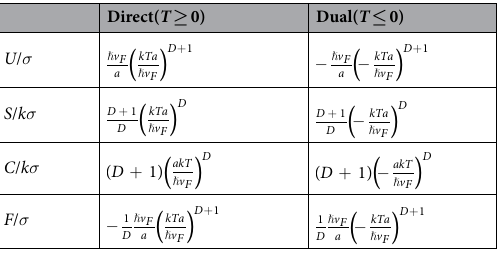
Table 1. Thermal properties of direct (electrons) and dual (holes) massless fermions in graphene at arbitrary dimension and temperature. Internal energy, entropy, specific heat and free energy, are